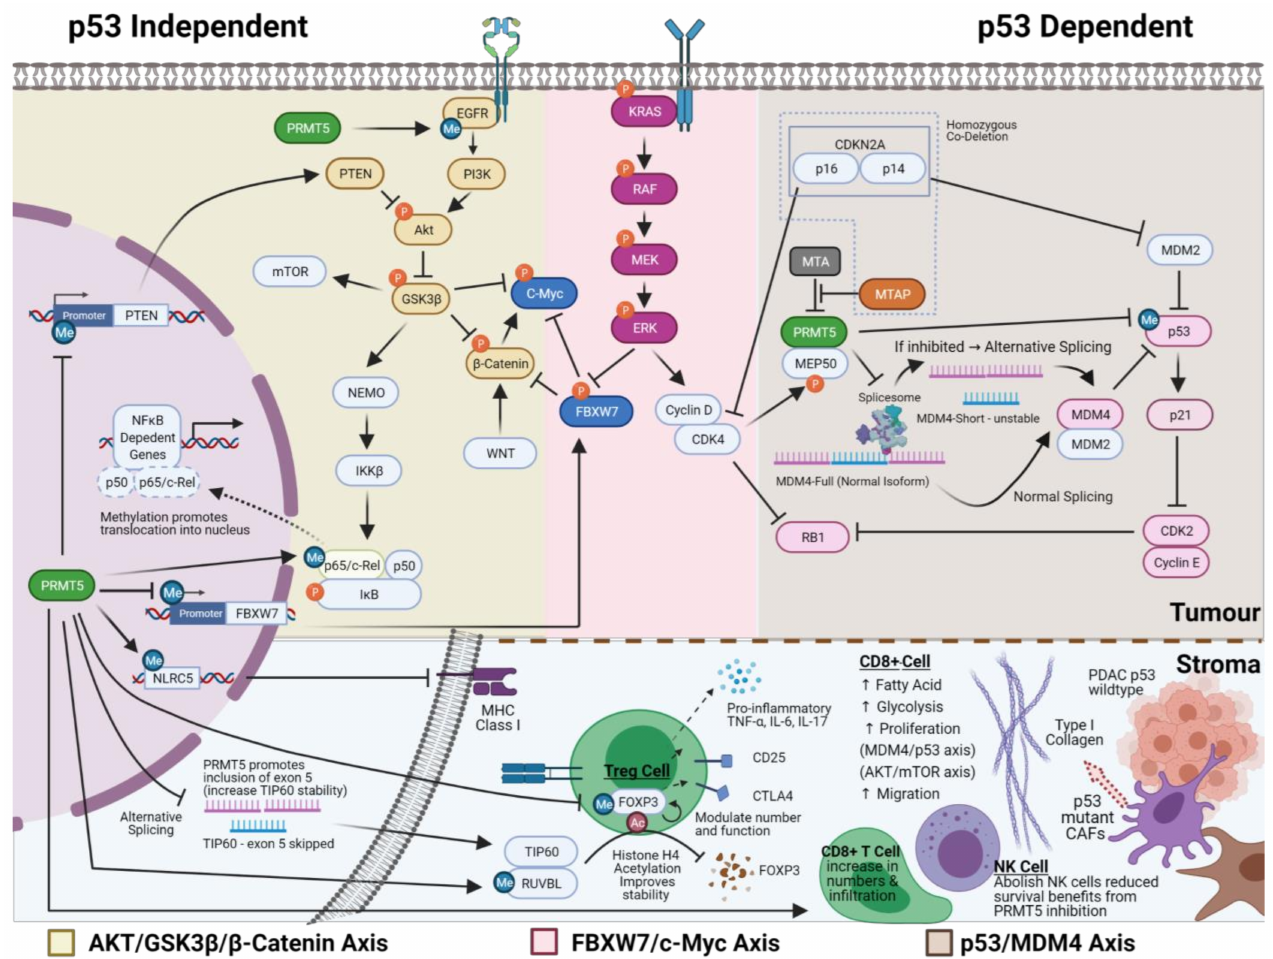
Figure 2. The mechanism of action of PRMT5. The figure portrays three best characterised axes of how PRMT5 can drive cancer growth that may be of relevance in PDAC, namely AKT/GSK3- β / β -Catenin axis, FBXW7/c-Myc axis and p53/MDM4 axis. The complex interplay between methylation, phosphorylation, acetylation and ubiquitination are denoted by blue (Me), orange (P) and brown (Ac) colours, respectively. The bottom panel highlights some of the possible effects that PRMT5 inhibition may have on the tumour microenvironment and how this relates to what we know about PDAC stroma and its interplay with PDAC tumour cells. Created with